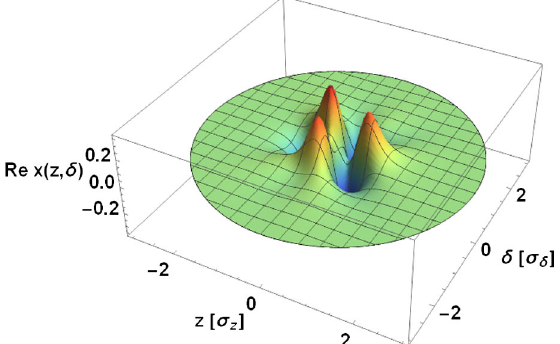
FIG. 9. Real part of dipole amplitude x ð z; δ Þ as a function of z and δ associated to the mode with fastest growth rate for σ ¼ 0 . 546 . The z and δ axes are in units of σ mode, where ν x σ δ , respectively. x is in arbitrary unit.